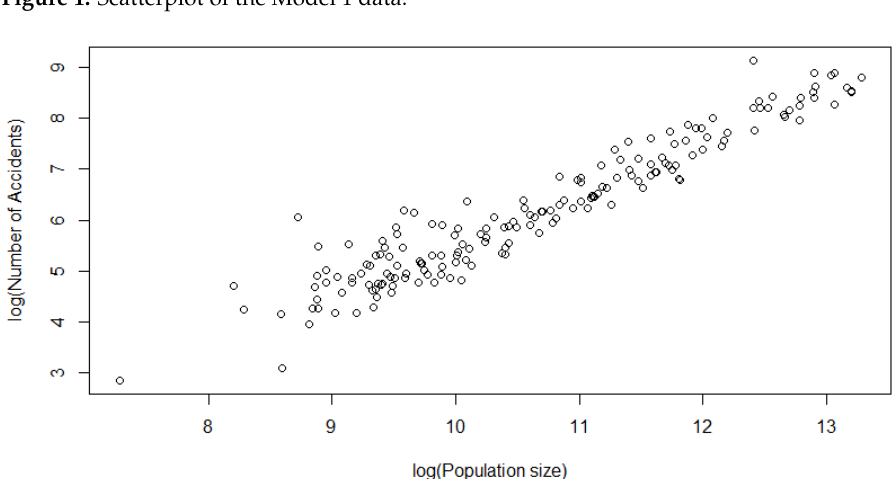
Figure 1. Scatterplot of the Model 1 data.